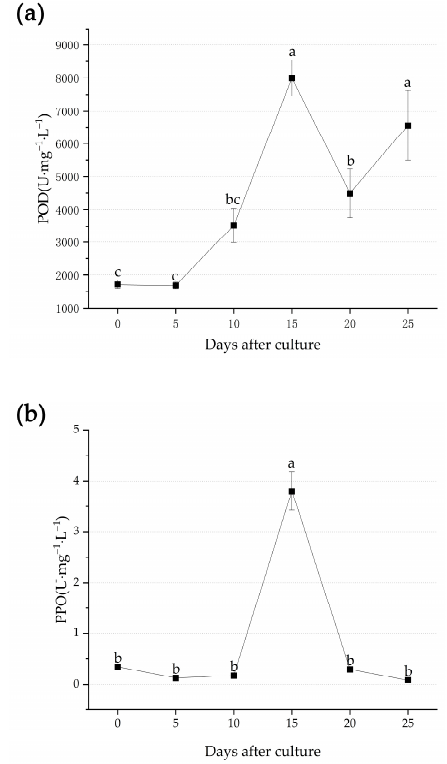
Figure 2. Anatomical analysis of in vitro rooting of B. buttiana ‘Miss Manila’. ( a ) Histological struc- ture on Day 0. ( b ) Histological structure on Day 5. ( c ) Histological structure on Day 10. The paren- chyma cells of the basic tissue continuously proliferate and form callus tissue. ( d ) Histological struc- ture on Day 15. Root primordia were gradually formed in the callus ( e ) The differentiated root pri- mordia continuously pushed outward in the cortex. ( f ) Adventitious roots, formed from root pri- mordia, penetrated the cortex and callus. ( g ) The adventitious roots pass through the epidermis and form roots vascularly connected with the stem. ( h ) Constant elongation of adventitious roots. The red frame shows precursor cells of adventitious root primordia and root primordium, and the red arrow shows growth direction of root primordium and adventitious root. Abbreviations: ep = epi- dermis; co = cortex; col = collenchyma; par = parenchyma; vc = vascular cylinder; vb = vascular bun- dle; prp = precursor of adventitious root primordia; cal = callus tissue; pi =